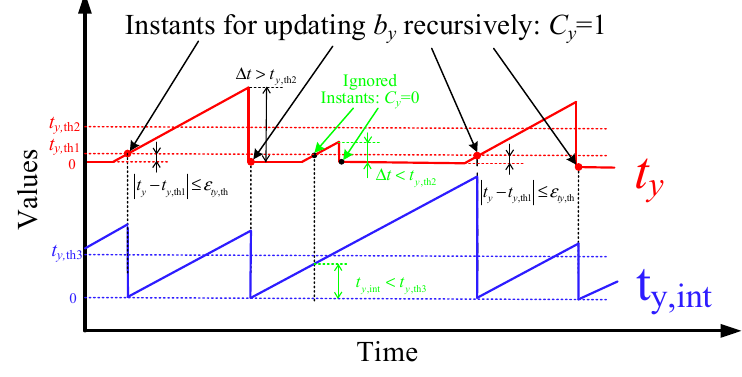
Figure 6. The instants for updating b y recursively.